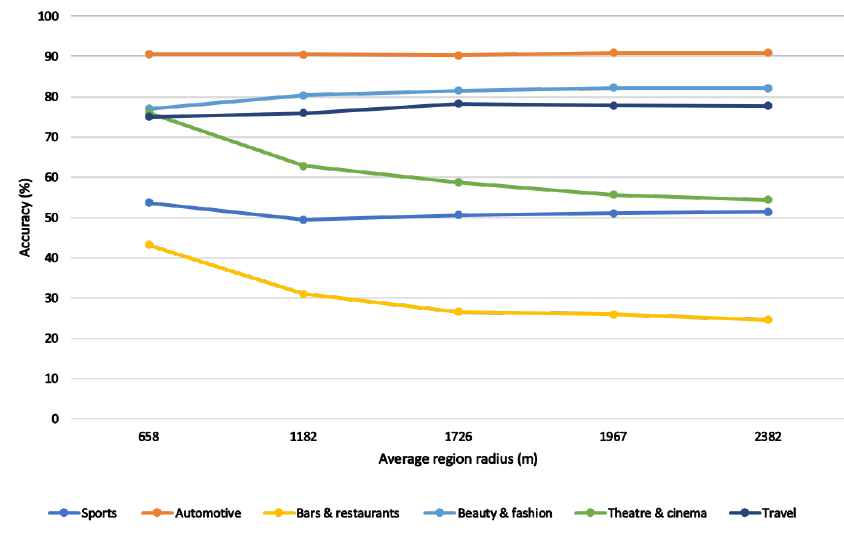
Figure 7. Accuracy of predictions in relation to average antenna’s